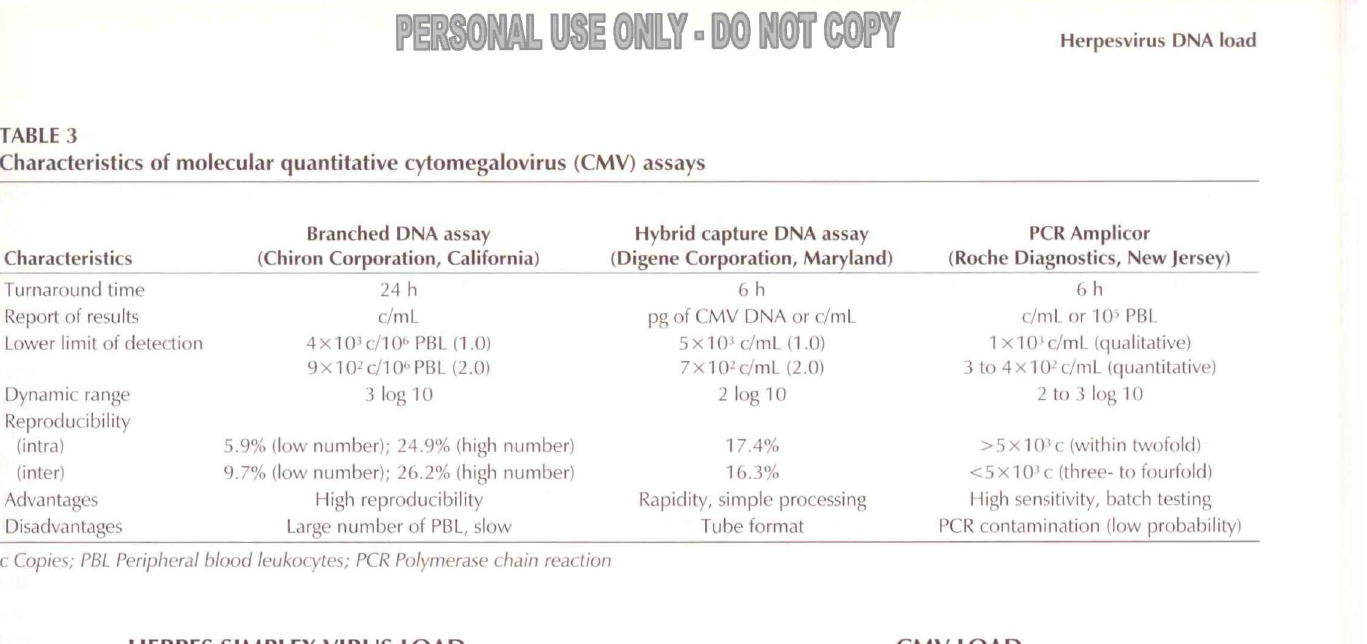
Characteristics of molecular quantitative cytomegalovirus (CMV) assays